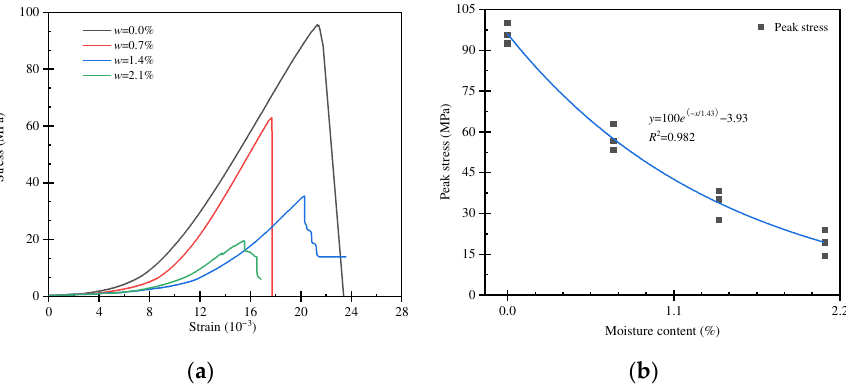
Figure 6. Mechanical damage characteristics of muddy sandstone with varying moisture content: ( a ) full stress–strain curves of muddy sandstone with different moisture contents; ( b ) peak stress fitting relationship of muddy sandstone with different moisture contents.